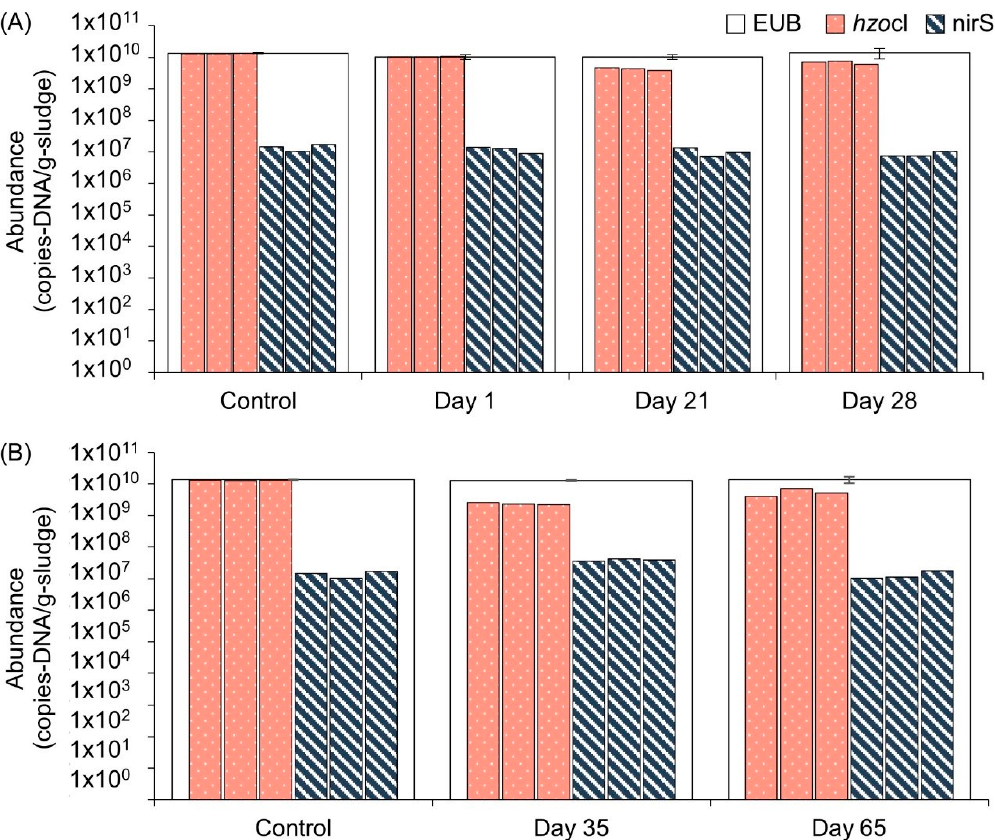
Figure 8. qPCR analysis of microbial abundance of ( A ) anammox and DNB, control, day 1, 21, and 28 during daily addition of COD from coffee wastewater ( B ) anammox and DNB, control day 35 and 65 during recovery.